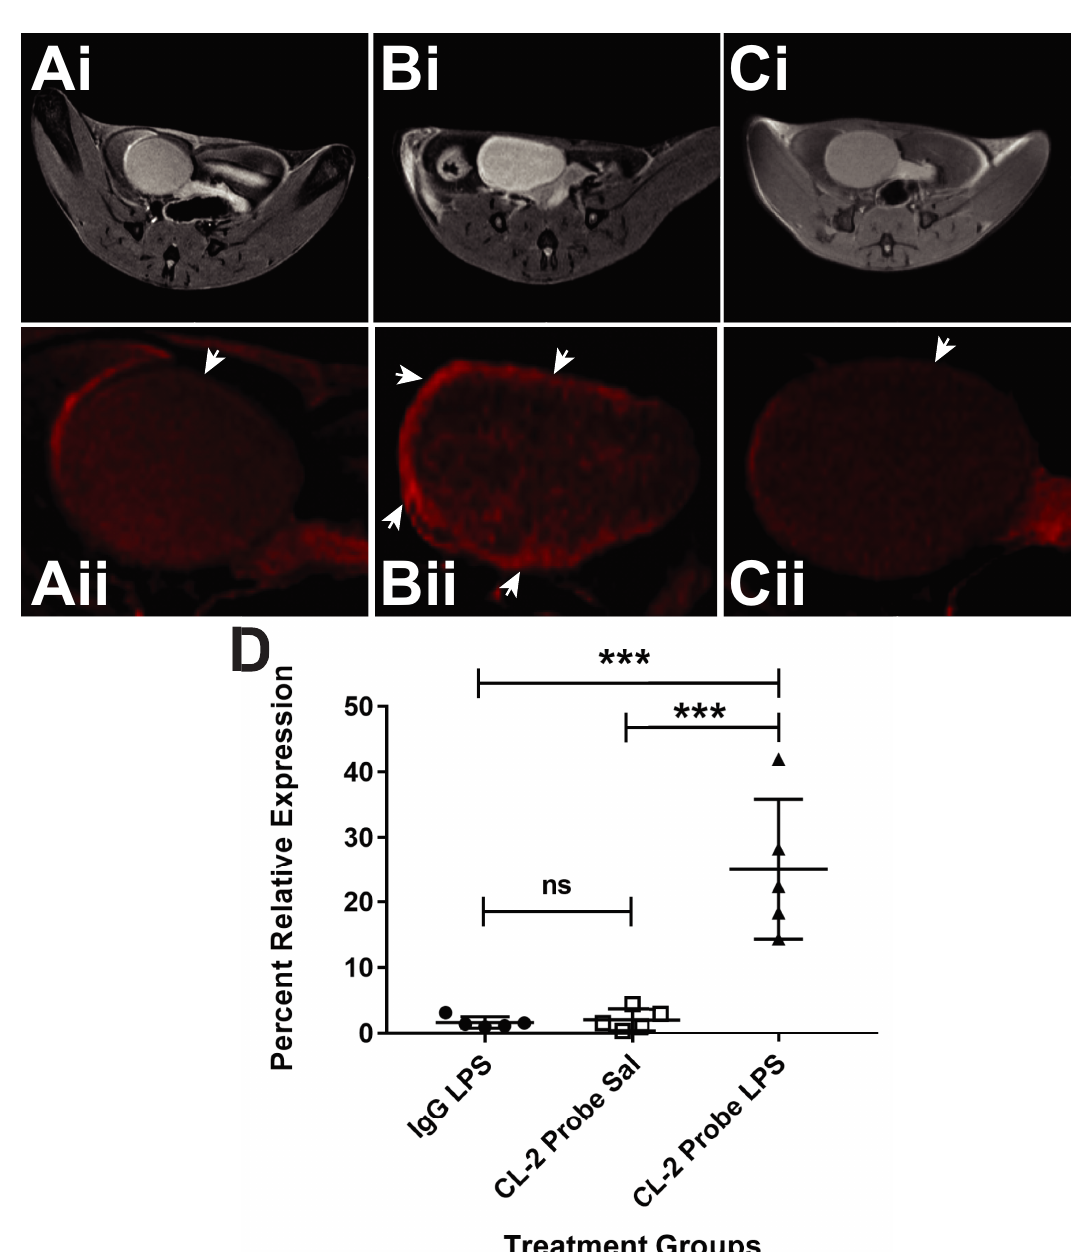
Fig 4. In vivo claudin-2 expression is increased in the LPS-exposed URO-MCP-1 IC mouse model. (A, B) Representative MR images (i) morphological or (ii) mt-MRI false-colored (red) images of URO-MCP-1 mouse bladders either treated with saline (A) or LPS (B) and the claudin-2 probe, or LPS and the non-specific IgG contrast agent (C). (D) Percent relative expression of Claudin-2, as measured by the percent increase in MRI T1 relaxation changes in either saline- or LPS-treated URTO-MCP-1 mouse bladders administered the Claudin-2 mt-MRI probe. A non-specific IgG contrast agent was used as a negative control in LPS-exposed mice. There was a significant increase in the detection of the Claudin-2 probe in LPS-treated URO-MCP-1 mice, compared to the saline control or LPS mice administered the IgG contrast agent ( ��� p < 0.001 for both). Statistical analysis involved using a two-way ANOVA with multiple comparisons